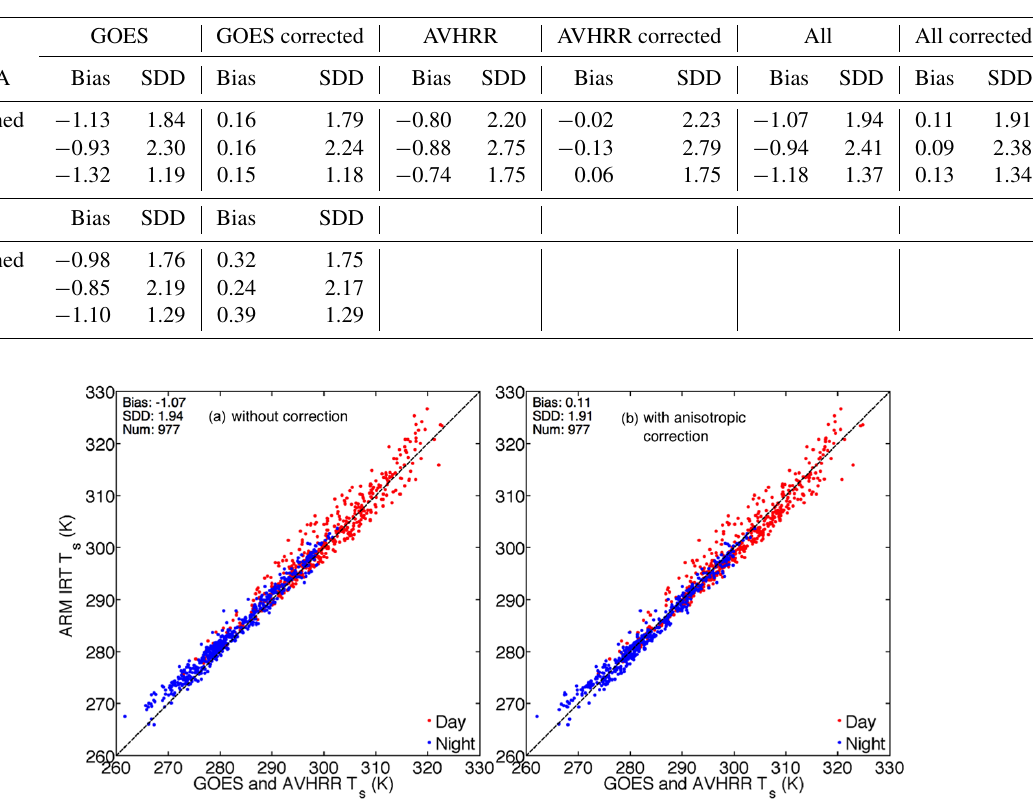
Figure 11. Scatterplots of clear-sky surface skin temperatures from 2013 GOES-13, GOES-15, and AVHRR imagery, matched with ARM SGP IRT temperatures (a) without and (b) with anisotropic